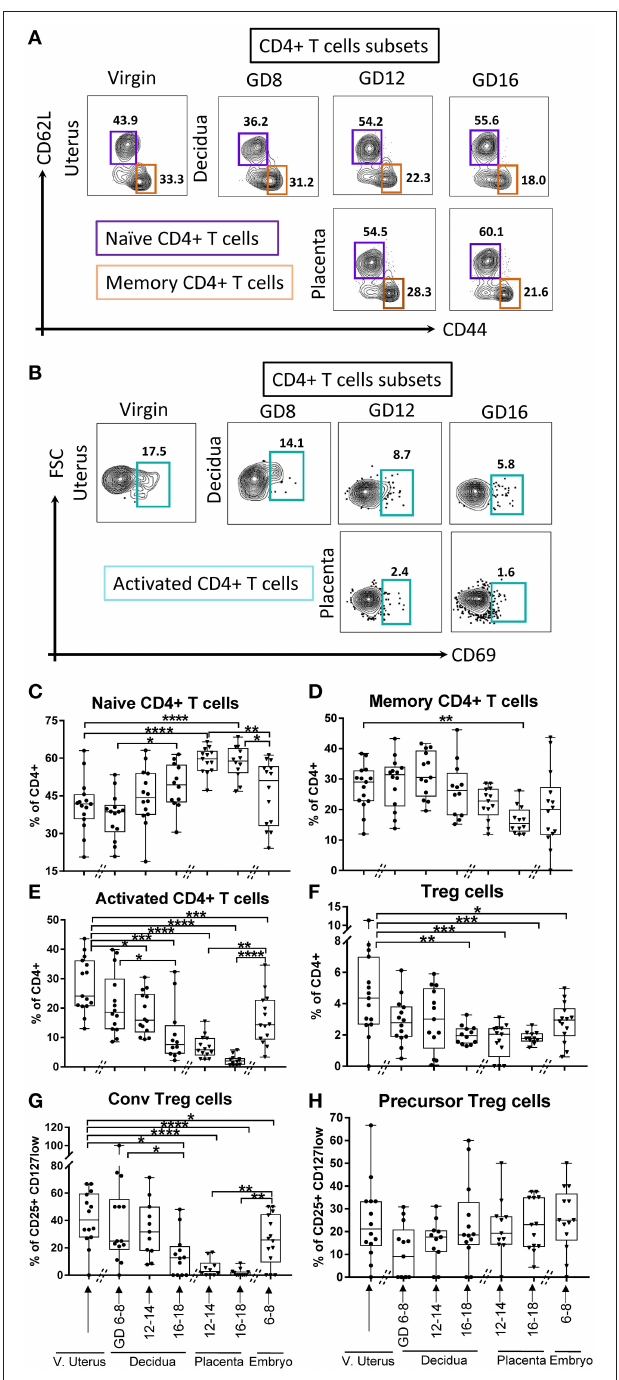
FIGURE 4 | Gating strategy and dynamics of CD4 + T cells subsets. (A) Gating strategy of Naïve CD4 + T cells, defined as lin2- (Ly6G neg B220 neg I-A/I-E neg ) TCR β + CD4 + CD62L + CD44 neg , and memory CD4 + T cells, defined as lin2- (Ly6G neg B220 neg I-A/I-E neg ) TCR β + CD4 + CD62L neg CD44 + . (B) Gating strategy of activated CD4 + T cells, defined as lin2-(Ly6G neg B220 neg I-A/I-E neg ) TCR β + CD4 + CD69 + . (C–E) Proportions of Naïve CD4 + T cells, memory CD4 + T cells, and activated CD4 + T cells in murine virgin uterus, decidua, placenta, and embryo across